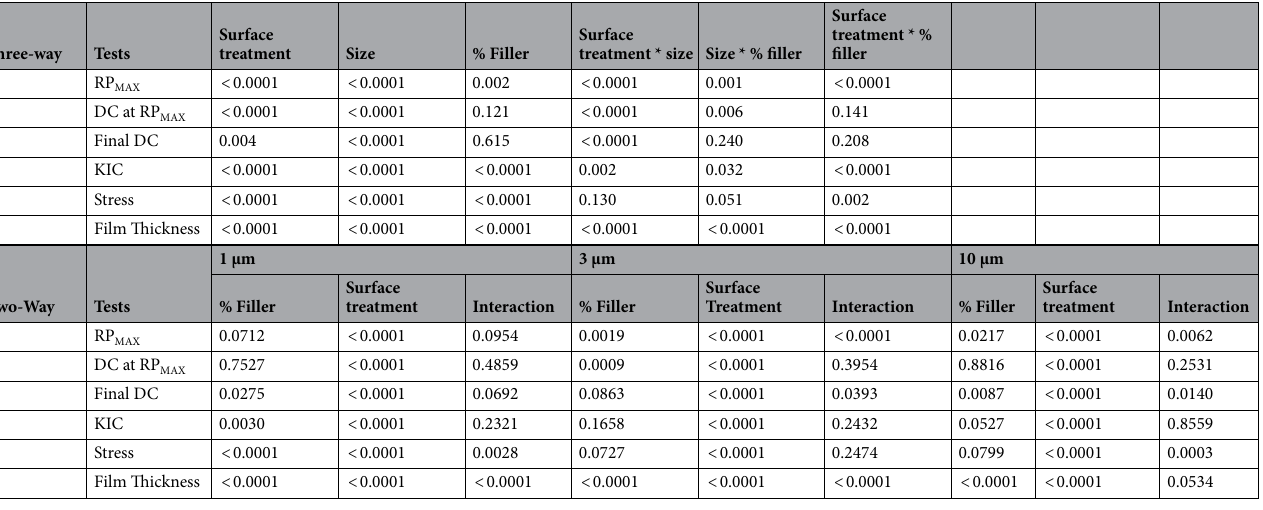
Table 1. Three and two-way ANOVA partitions (p values). Three-way ANOVA analyzed the three variables and their interaction in all experiments. Two-way ANOVA considered the effect of the filler amount, particle surface treatment and interaction between the two factors for each filler particle size in all experiments. The significance level was α = 0.05for both analyses.